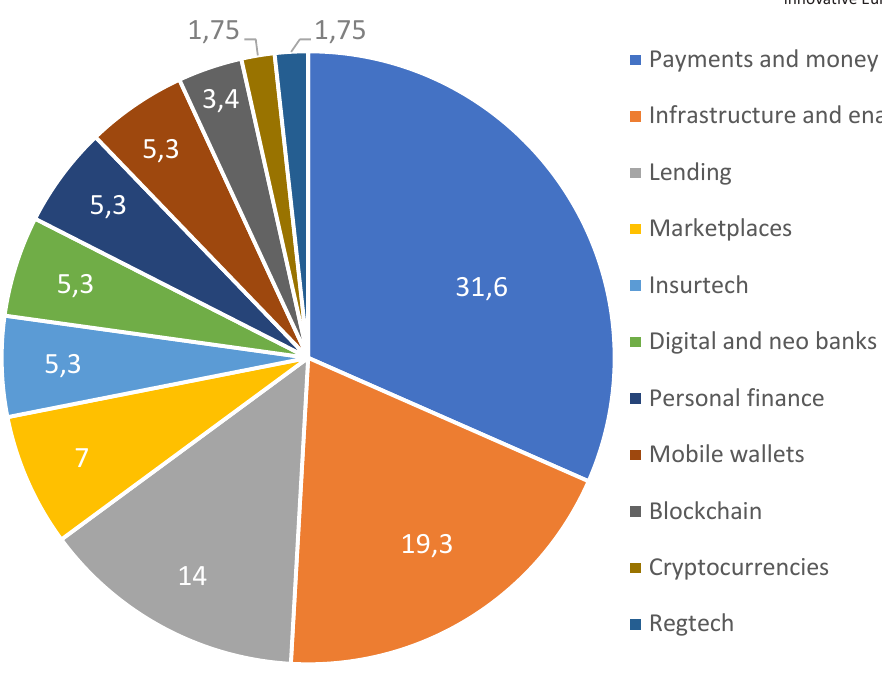
Figure 6. FinTech categories performed by Ukrainian